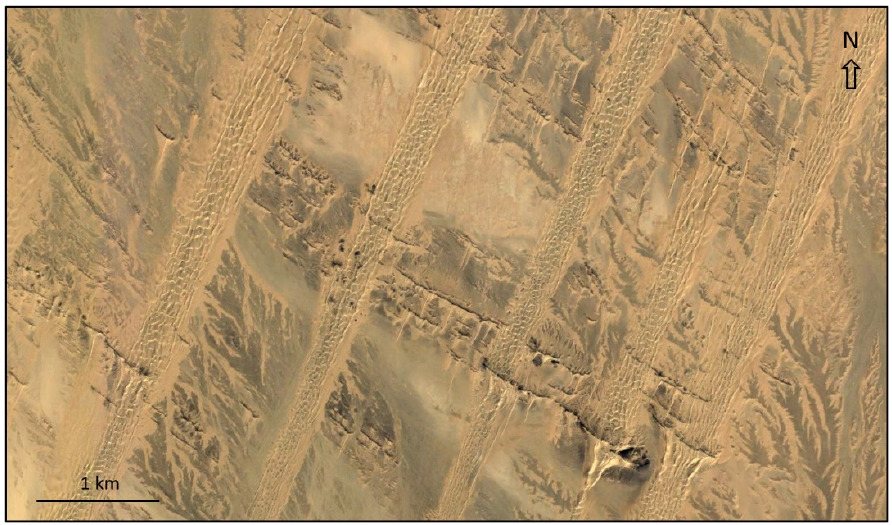
Figure 9. Compound linear dunes of El-Hebal Dune Field. Source: Google Earth image © 2019 CNES/Airbus.